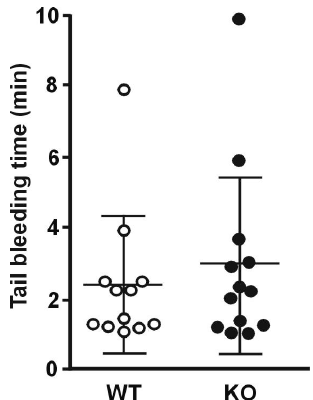
Figure 7. Tail bleeding time. Tests were performed by cutting off 3 mm of the tail tip and placing the tail in 37 °C saline. The time until hemostasis was recorded for up to 10 min and re ‐ bleeding monitored for 60 s beyond hemostasis. Data represent average ± SD of 12–13